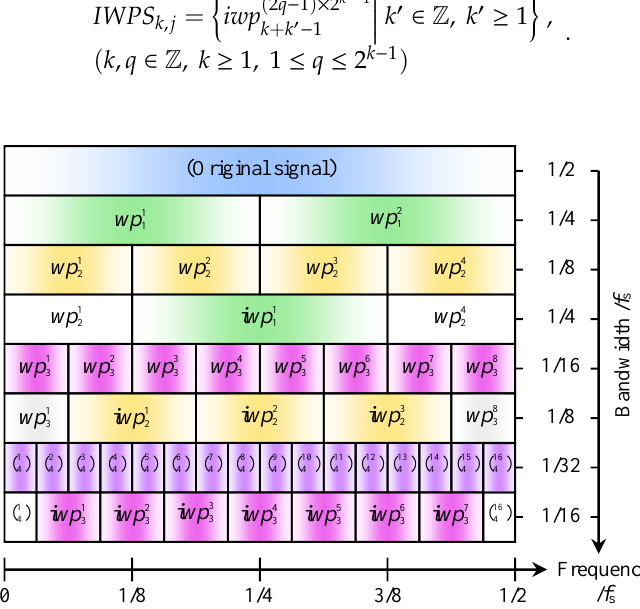
Figure 3. Frequency-scale paving of derived wavelet frames (DWFs).